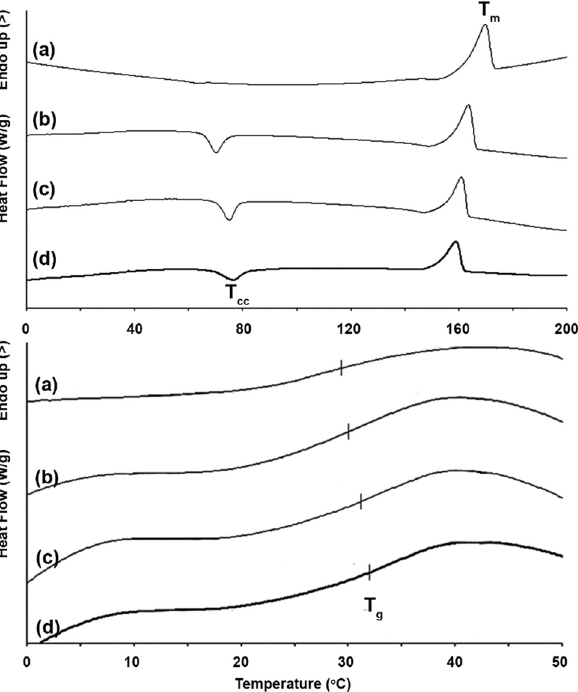
Figure 2: DSC heating curves ( upper diagram ) and expanded glass - transition regions ( lower diagram ) of PLLA - PEG - PLLA: ( a ) without CE and with CE contents of ( b ) 1.0, ( c ) 2.0, and ( d ) 4.0 phr.